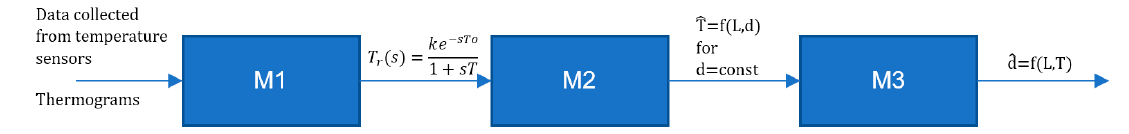
Figure 9. Steps of the analysis with marked primary input and output data.